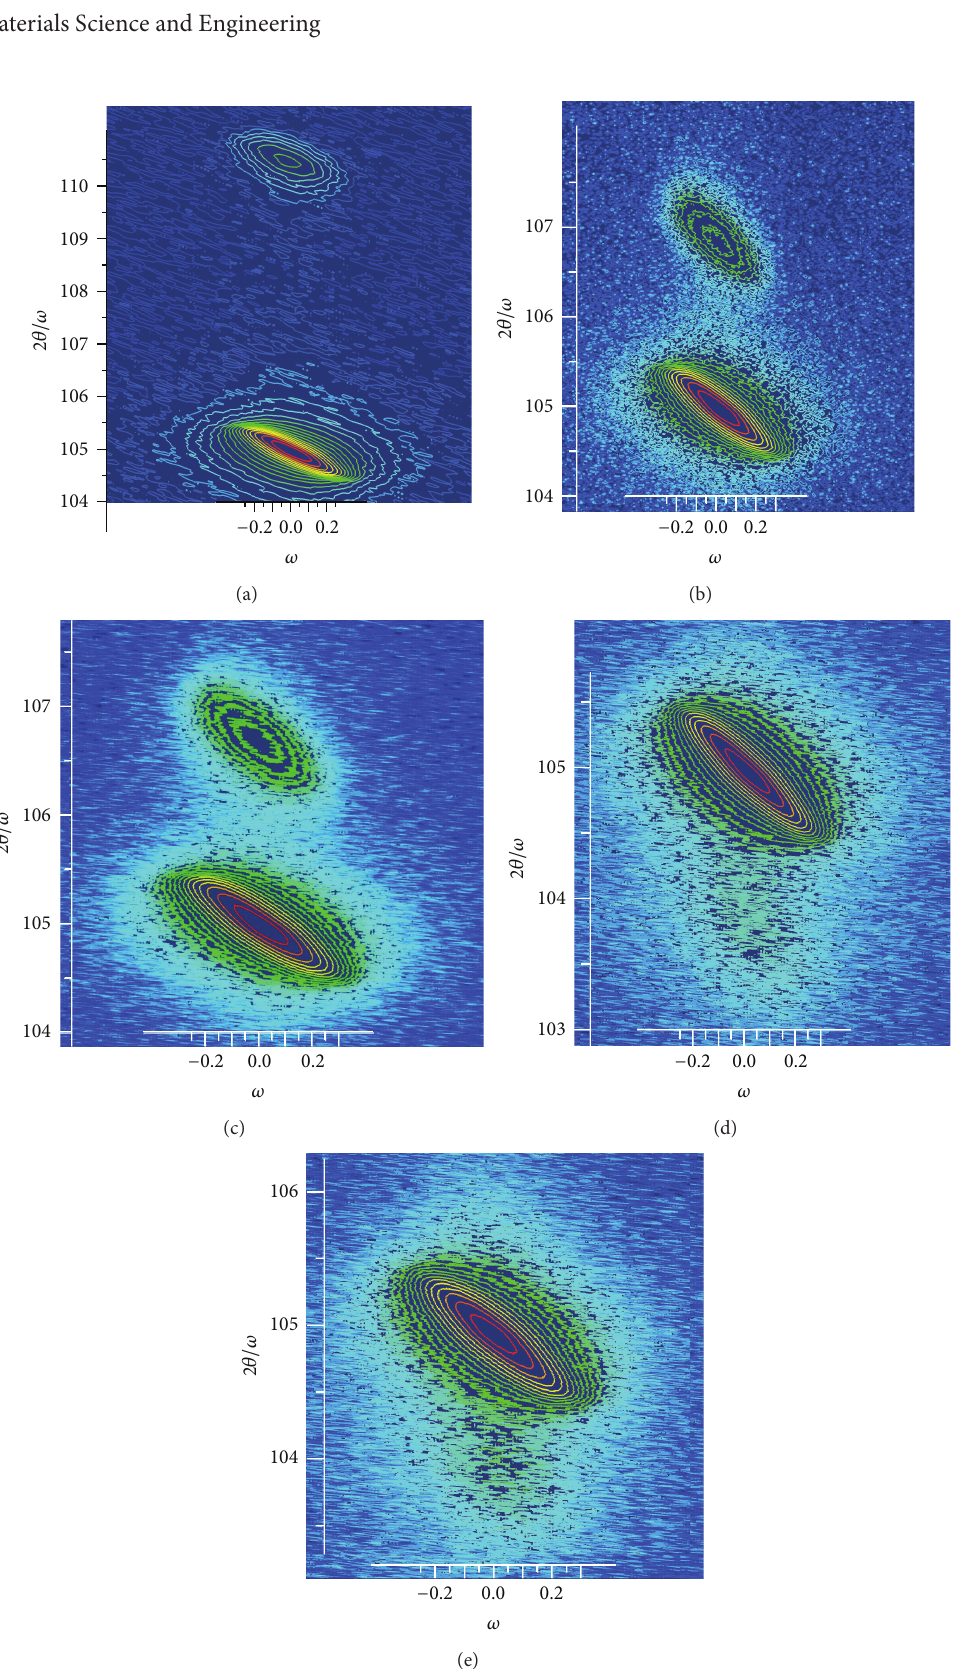
Figure 6: HR-XRD reciprocal space-maps of the (10–15) reflection for AlInN/GaN/Al 2 O 3 structures with different indium content. In content changes as (a) 4%, (b) 18%, (c) 20%, (d) 47, and (e)